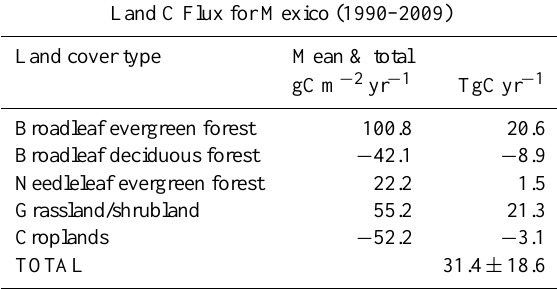
Table 5. Land C flux to the atmosphere (NBP) for the period 1990– 2009 by land cover type. For all cases a positive value indicates a sink and a negative value a